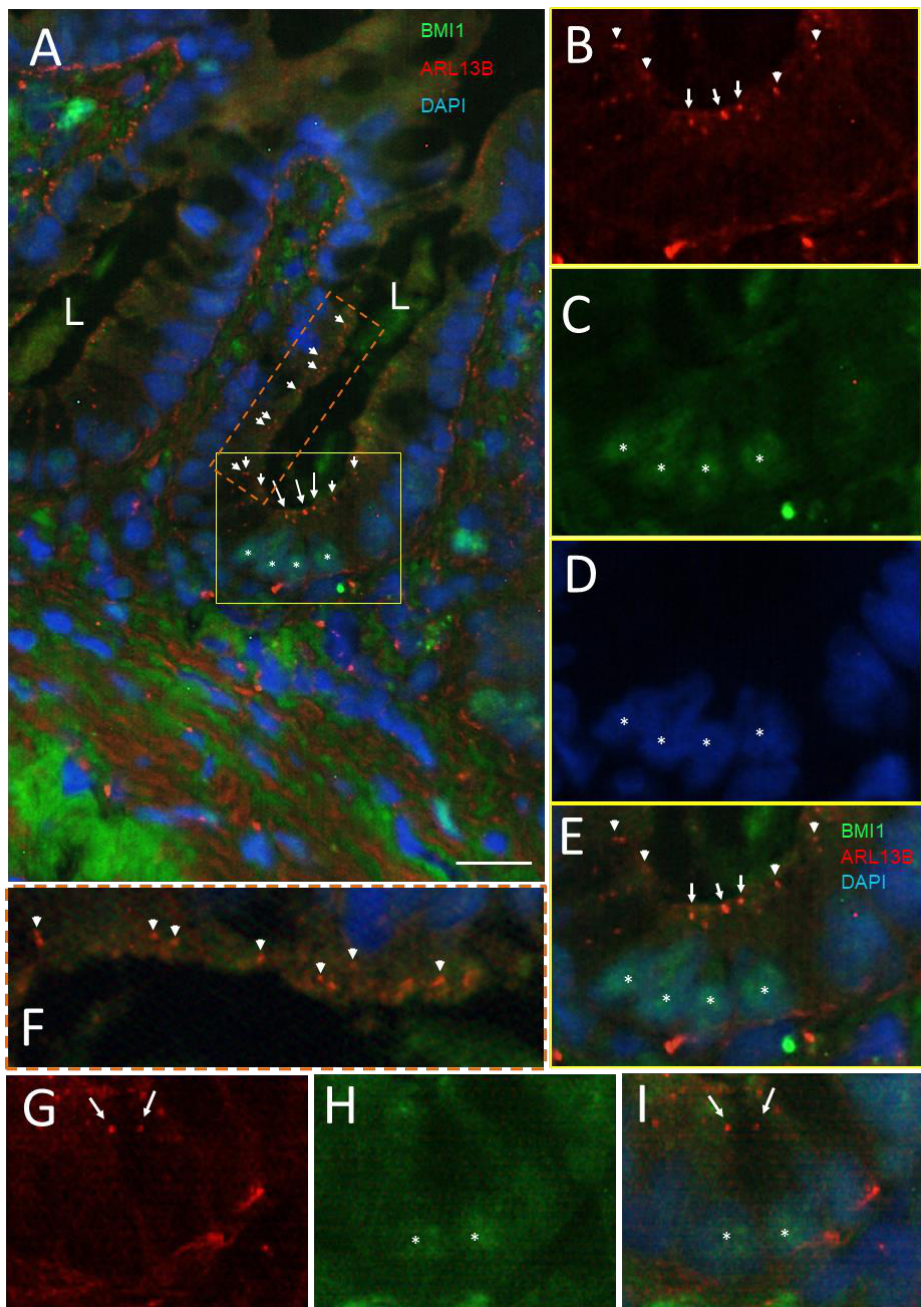
Figure 4. Primary cilia in BMI1-positive cells of the crypts of the human small intestine. ( A ) Repre- sentative immunodetection of primary cilia using the anti-ARL13b 17711-1-AP antibody (arrow, red staining) and positive BMI1 nuclei (green staining, stars) in epithelial crypt cells of the human adult small intestine (L, lumen of the crypts). Nuclei were stained with DAPI (blue). The square delimits the portion of the lower crypt shown in panels ( B – E ) and the rectangle delimits the portion of the luminal crypt epithelium shown in panel ( F ). ( B – E ) Higher magnification of the lower crypt region showing a cluster of positive 17711-1-AP structures in the luminal aspect of lower crypt cells (arrows in B , E ) and positive nuclei for BMI1 staining (stars in C , E ). Arrowheads in the ( A , B , E , F ) panels identify smaller 17711-1-AP-stained dots that do not seem to be related to the primary cilium. ( G , H ) Another region showing the expression of 17711-1-AP-stained structures (arrows) in cells displaying positive BMI-1-stained nuclei (stars). Nuclei were stained with DAPI ( A , D , E , I ). Scale bar is equal to 10 µ